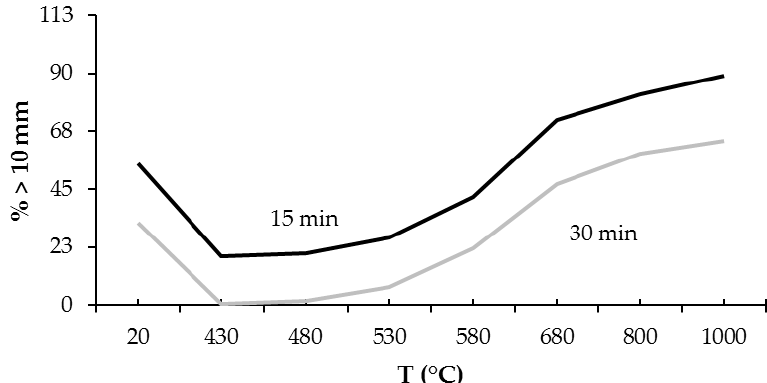
Figure 3. Degradation resistance loss as a function of temperature (refractory cement).